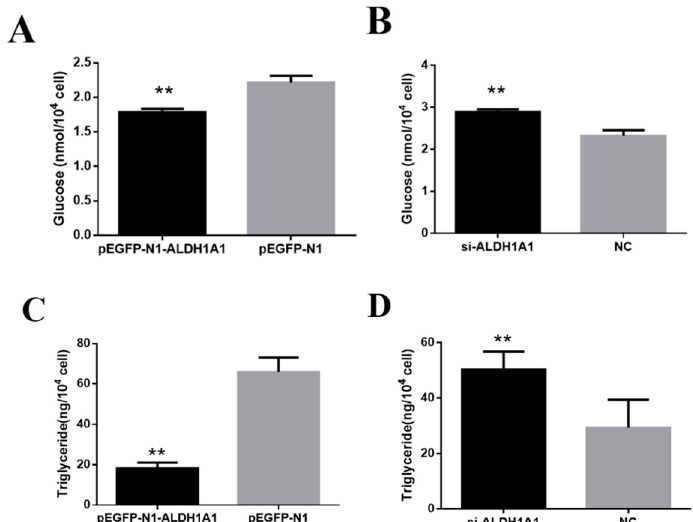
Figure 5. ALDH1A1 inhibits glucose accumulation in chicken preadipocytes. ( a, b ) Glucose content in in chicken primary preadipocytes after transfection and di ff erentiation for three days ( n = 6). chicken primary preadipocytes after transfection and differentiation for three days ( n = 6). ( c, d ) ( C , D ) Triglyceride accumulation in the preadipocytes after di ff erentiation for five days was detected Triglyceride accumulation in the preadipocytes after differentiation for five days was detected under under 420 nm ( n = 6). Statistical significance of the di ff erences between the means was assessed using 420 nm ( n = 6). Statistical significance of the differences between the means was assessed using an an unpaired Student’s t -test (** p < 0.01) vs. negative control unpaired Student’s t -test (** p < 0.01) vs. negative control (NC).